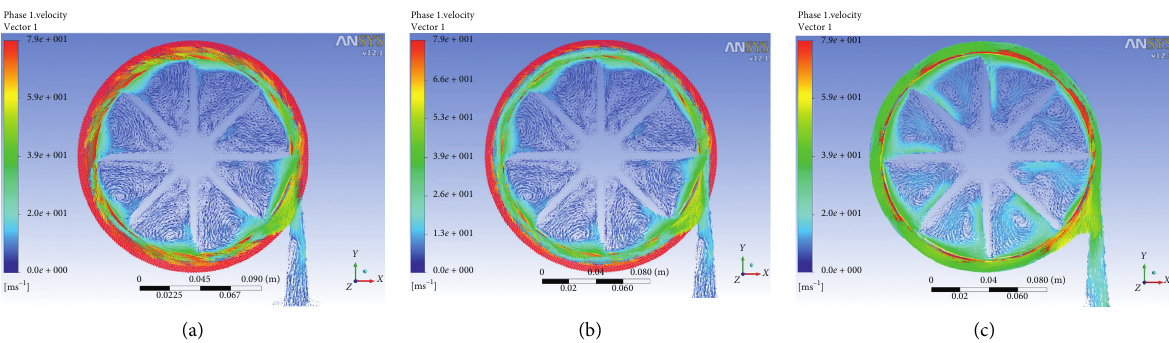
Figure 14: Liquid phase velocity vector distribution under different flow rates. (a) Q